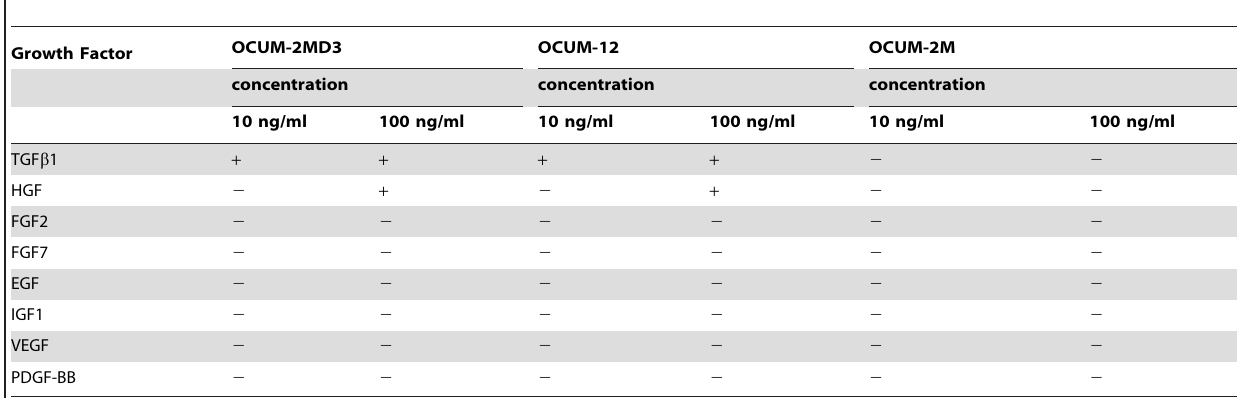
Table 1. Effects of various growth factors on cancer cell